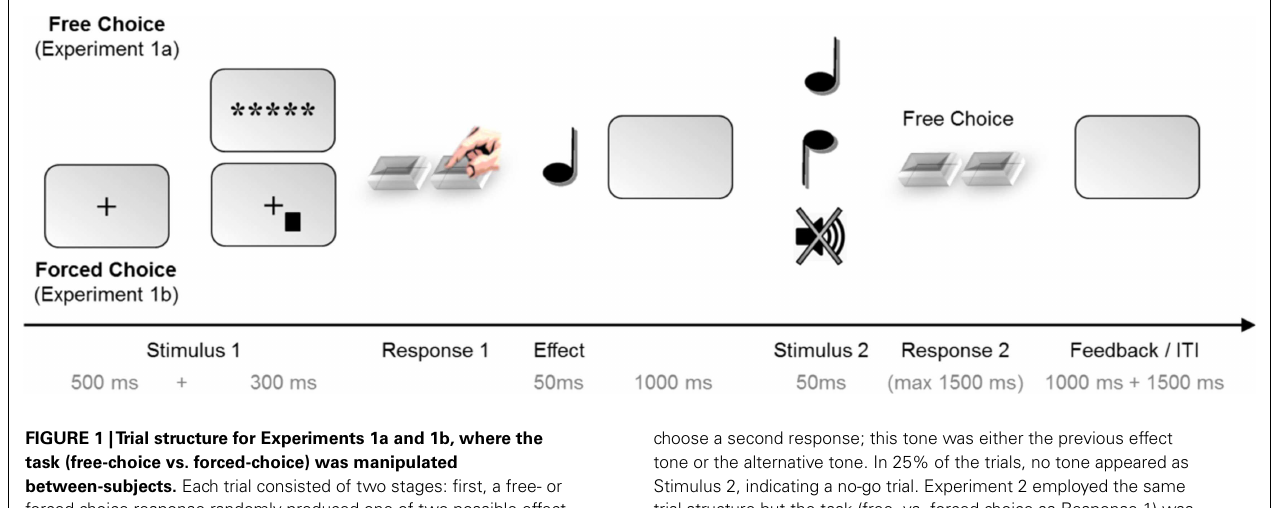
FIGURE 1 |Trial structure for Experiments 1a and 1b, where the task (free-choice vs. forced-choice) was manipulated between-subjects. Each trial consisted of two stages: first, a free- or forced-choice response randomly produced one of two possible effect tones.Then, a second tone appeared and prompted the participants